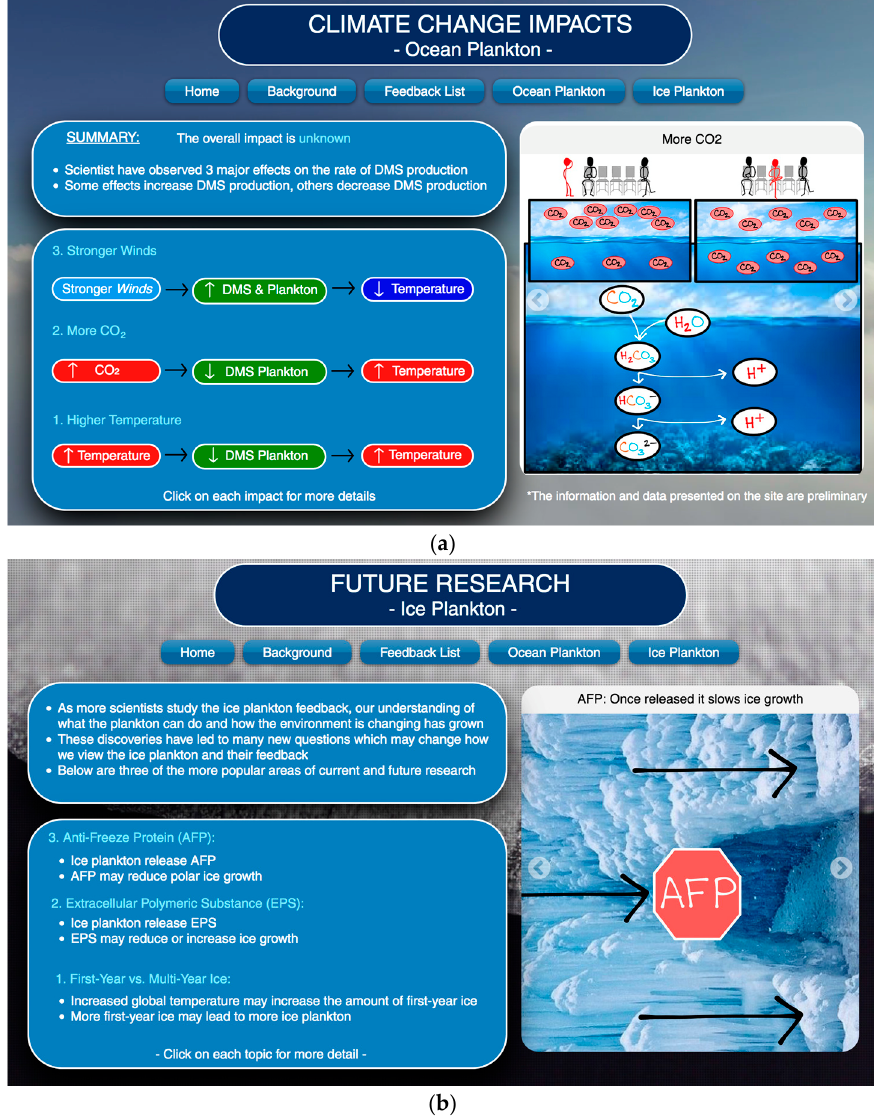
Figure 3. The “Climate Change Impacts” page for the DMS cloud-albedo feedback ( a ) and the “Future Research” page for the ice chlorophyll feedback ( b ) taken directly from the website. The climate change impact image includes a representation of a stick figure deciding where to sit. On the website, this illustration is used to demonstrate that both nature and a person choosing a seat will naturally spread out. This parallel is used to explain the scientific concept of diffusion. The future research image visualizes expansion of ice from the left to right side of the picture. However, the exudate -AFP- infers with the growth.